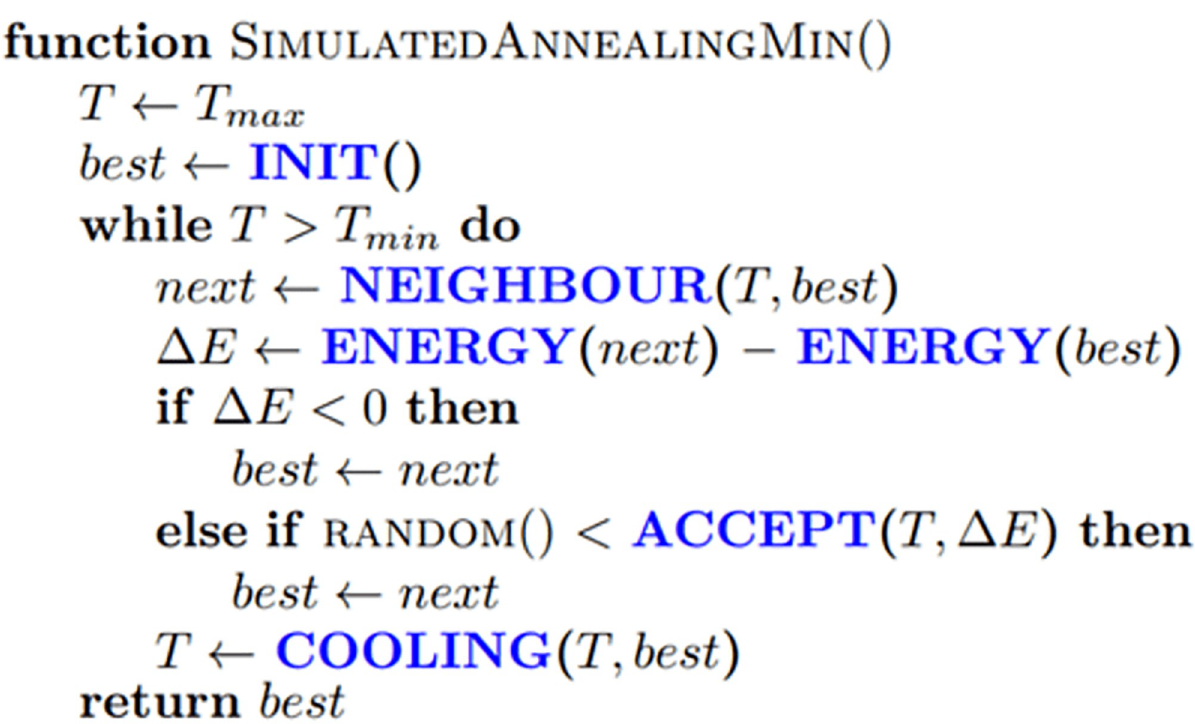
Fig 4. Simulated annealing algorithm.